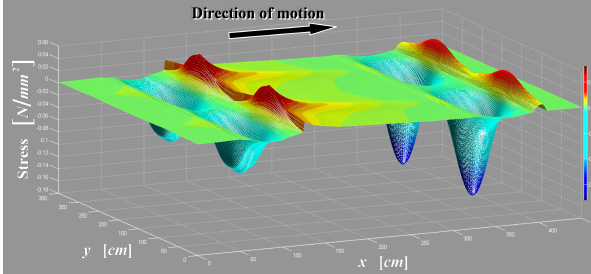
Figure 2: Vertical stresses induced near the surface by the front and back wheels (from [2]).